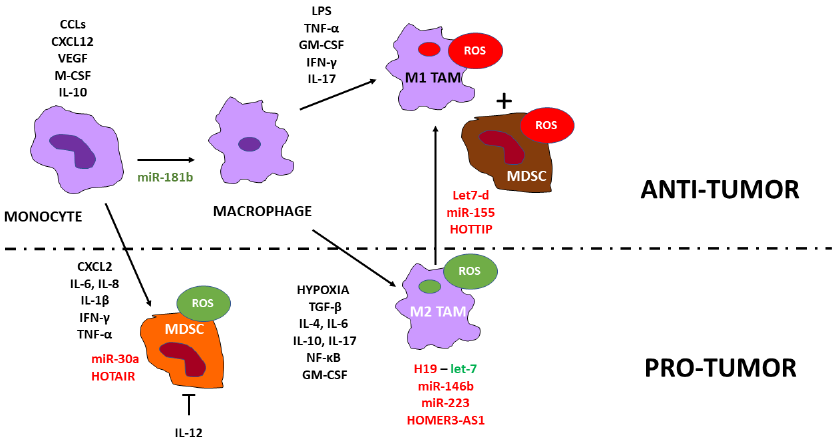
Figure 4. Control of MDSC and macrophage function and oxidative stress by noncoding RNAs. Monocytes and polymorphonuclear cells may differentiate into MDSCs. CXC motif chemokine ligand 2 (CXCL2) released by tumor cells, which in turn activates CXC chemokine receptor 2 (CXCR2), and IL-6, IL-8, and IL- 1β recruit tumor -infiltrating MDSCs. In the early stages, NOX2 is the primary source of ROS essential to maintain the undifferentiated state of MDSCs. Cancer cell-derived IL-6 activates MDSCs. MDSCs secrete TGF- β1, inhibiting antigen -specific CD8 + T-cell effector functions,